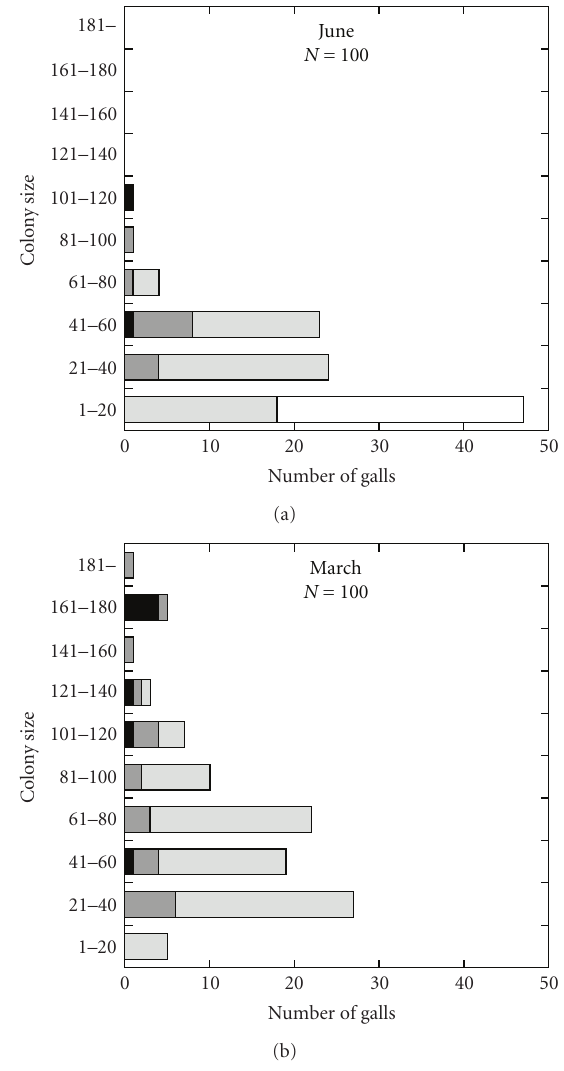
Figure 4: Colony size (number of live aphids) for 100 cone-shaped galls of Nipponaphis monzeni collected on 2 June 2008 (a) and 31 March 2007 (b). Those galls that contained zero, from one to five, from six to 20, and more than 20 dead aphids are indicated by white, light gray, dark gray, and black areas, respectively, on the